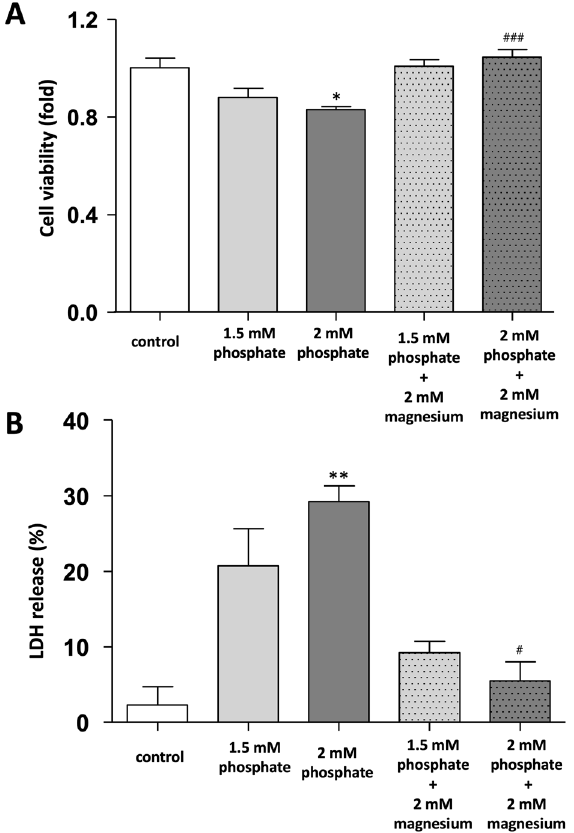
Figure 3. Effects of phosphate and magnesium on DolKT-1 cell viability and injury. Cell viability was quantified by the WST-1 assay after 48 h of exposure with various experimental groups and expressed as the fold change with the live cells in the control group ( A ). n = 4 or 5 for each group. Cytotoxicity was detected by LDH assay after 48 h of exposure ( B ). n = 5 for each group. *P < 0.05, **P < 0.01 vs. control; # P < 0.05, ### P < 0.001 vs. 2 mM phosphate, respectively. WST-1 water-soluble tetrazolium salt-1, LDH lactate